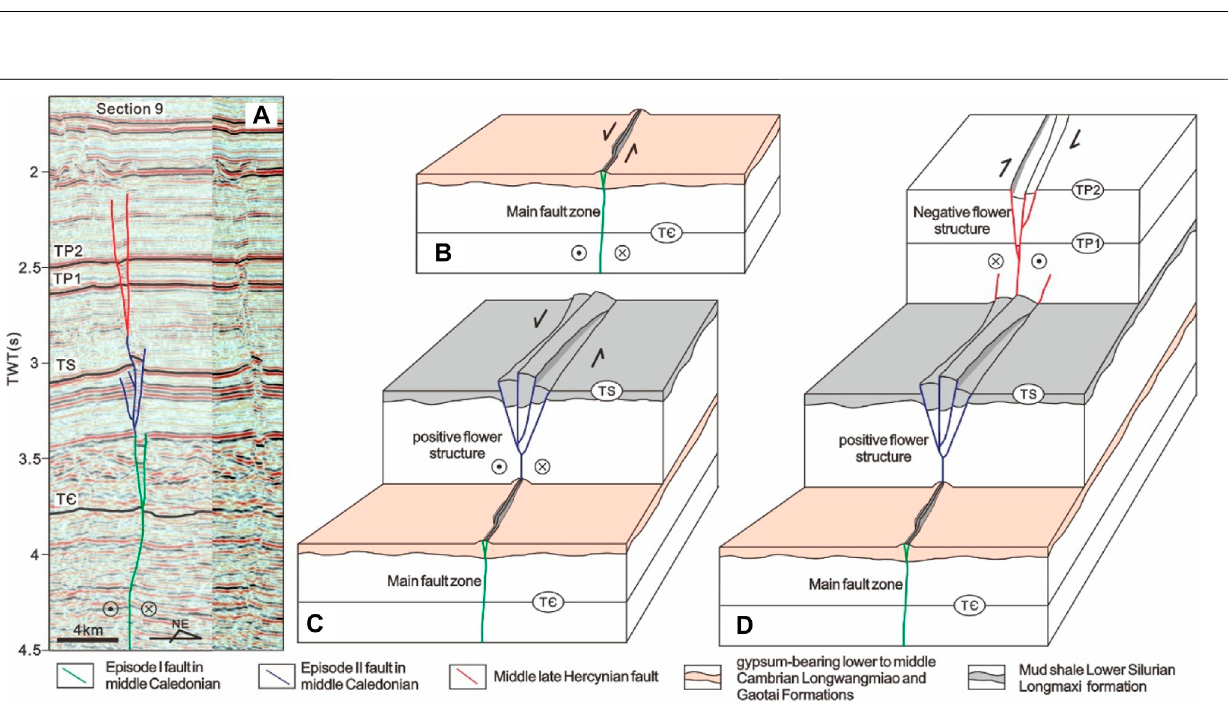
FIGURE 12 | (A) Fault interpretations of cross Section 9 ( Figure 3 for the de fi nition of surfaces) and (B) – (D) Schematic model showing the structural evolution of individual strike-slip fault zones within a three-dimensional perspective.